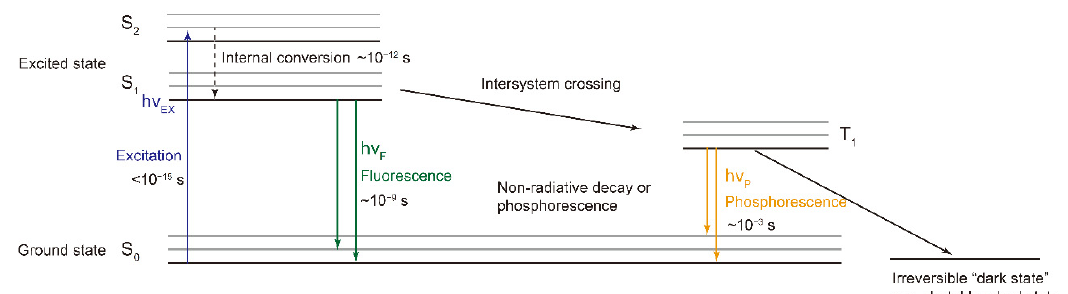
Figure 1. Jablonski diagram for the electronic energy levels of a fluorophore and the transitions between them.